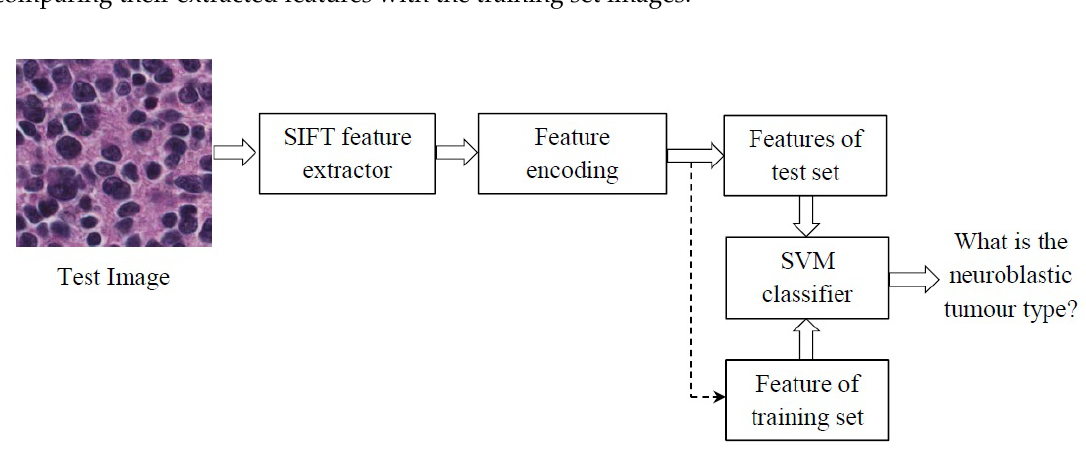
Figure 5. The scheme of the proposed method. SIFT, Scale Invariant Feature Transform; SVM, Support Vector